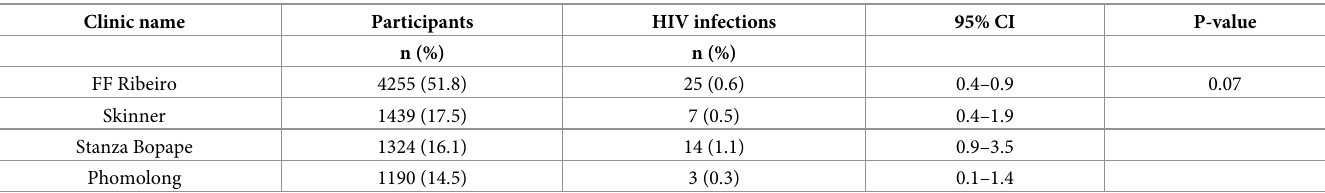
Table 1. Distribution of participants and HIV infections by